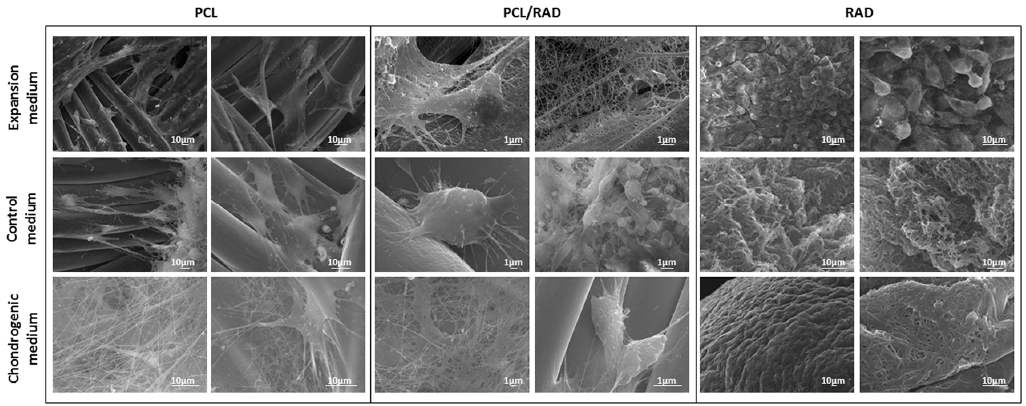
Figure 5. Scanning Electron Microscopy (SEM) images of Articular Chondrocytes (AC) cultured in 3D scaffolds after 4 weeks. AC were seeded into PCL, PCL/RAD, and RAD scaffolds and cultured with expansion, control, and chondrogenic media. Two images per condition were shown.